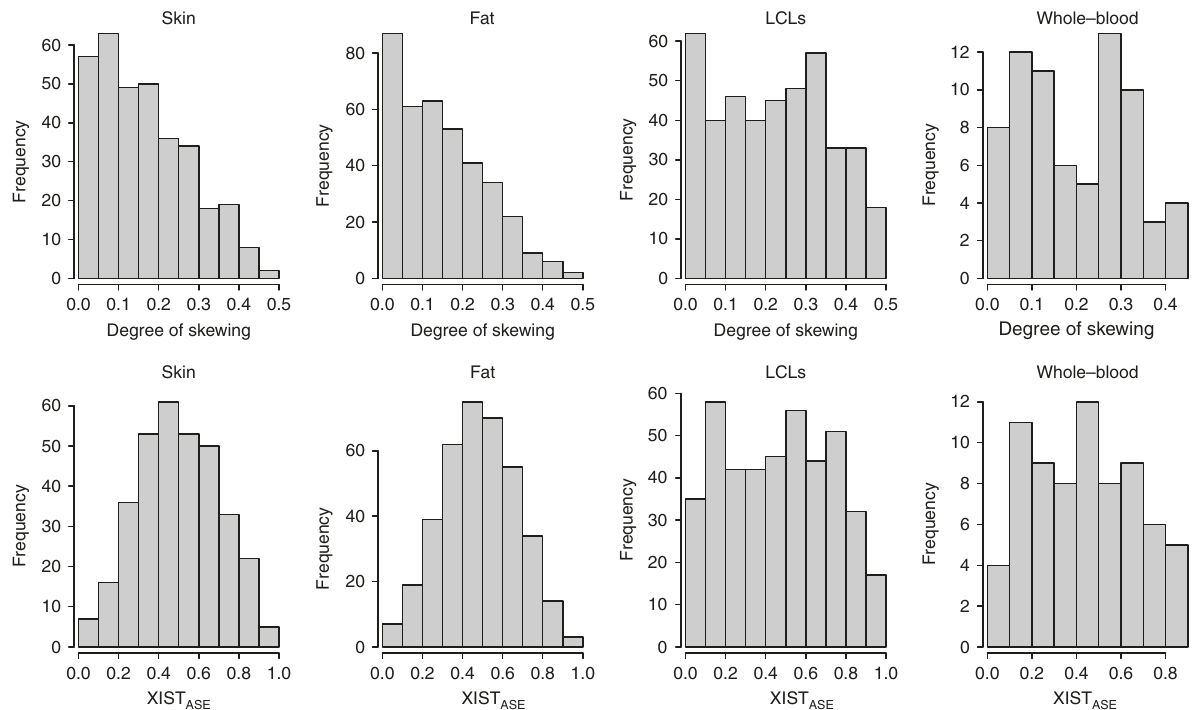
Fig. 2 Skewed X-inactivation varies across tissues with a higher prevalence in blood than fat and skin tissues. Distribution of the degree of skewing (top row) and XIST ASE (bottom row) in LCLs ( n = 422 samples), whole-blood ( n = 72 samples), fat ( n = 378 samples) and skin ( n = 336 samples) tissues. XIST XIST allele-speci fi c expression. ASE